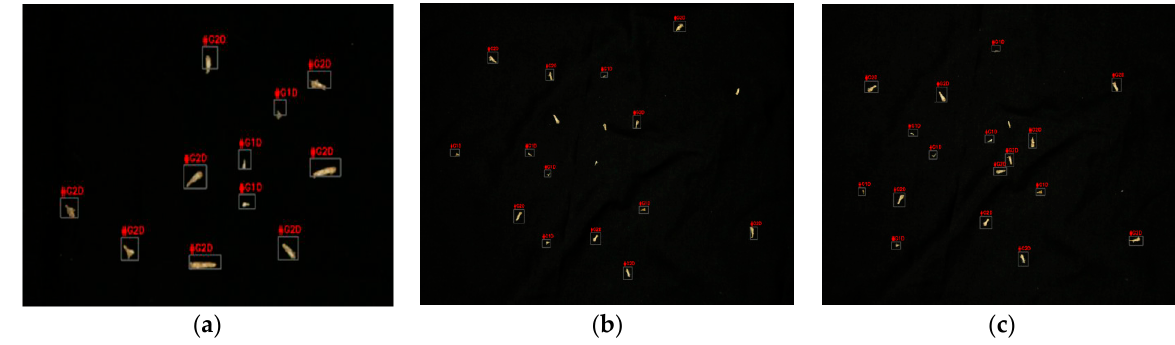
Figure 14. Detection accuracy based on different image analysis techniques according to the Stage 1&2 and Stage 3 methods at different camera distances. Note: Bars across a group with the different letters were significantly different ( p < 0.05) after the LSD test.